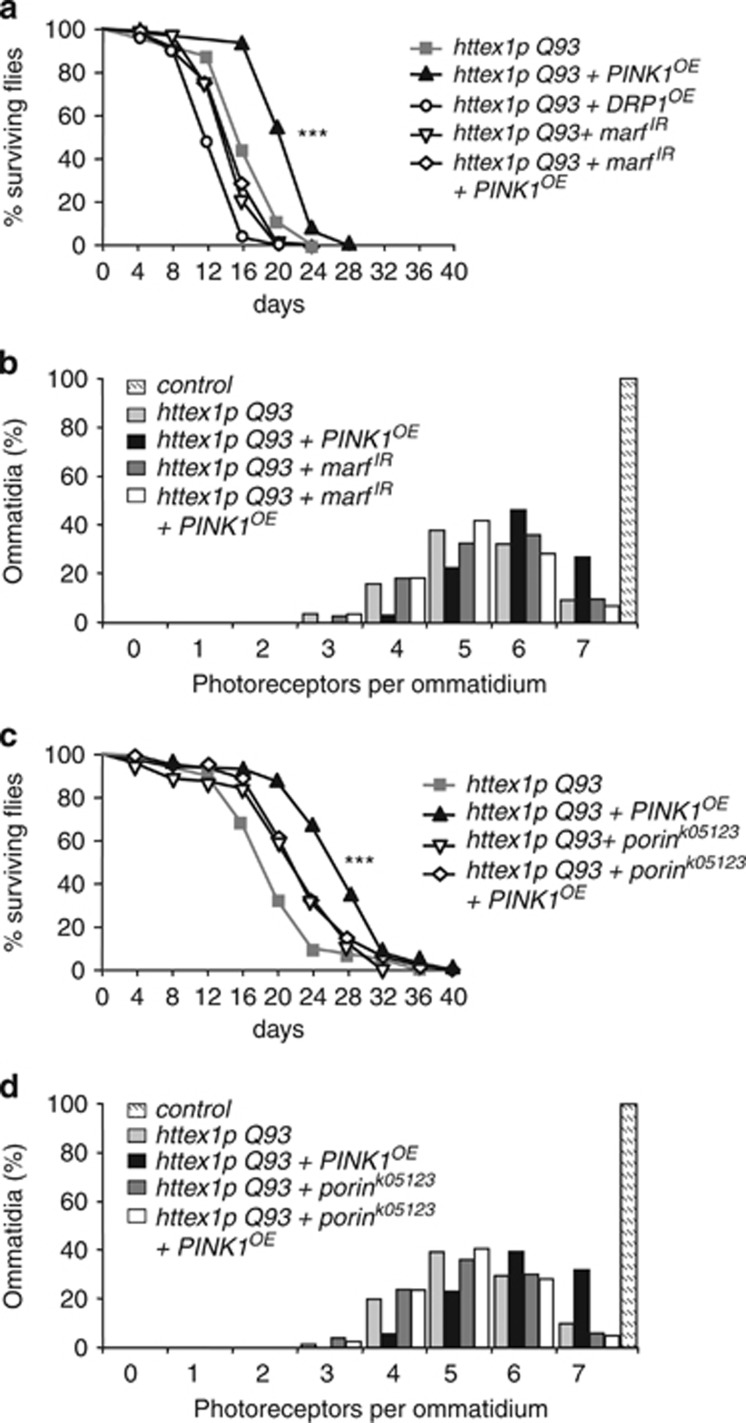
Decreasing Mfn/Marf and VDAC/Porin reduce PINK1 neuroprotective effect. (a) Survival rates of flies expressing httex1p Q93 alone, httex1p Q93 with RNA interference (RNAi) against mfn/marf (marfIR), httex1p Q93 with a DRP1 transgene (DRP1OE), httex1p Q93 with PINK1OE or httex1p Q93 together with PINK1OE and marfIR in neurons. Silencing Mfn/Marf reduces the PINK1 neuroprotective effect on the survival of HD flies. Statistical significance was determined by the log-rank test (n>60 flies per genotype; ***P<0.0001). (b) Number of photoreceptors per ommatidium in 4-day-old flies expressing no transgene (control), httex1p Q93 alone, httex1p Q93 with PINK1OE, httex1p Q93 with the RNAi transgene marfIR or httex1p Q93 together with PINK1OE and marfIR in neurons (n=7–10 flies per genotype; P<0.0001, Mann–Whitney U-test). (c) Survival rates of flies expressing httex1p Q93 alone, httex1p Q93 with PINK1OE, httex1p Q93 in the presence of one mutant allele of VDAC/porin (porink05123) or httex1p Q93 together with PINK1OE and porink05123. Loss of function of Porin prevents the PINK1 neuroprotective effect on the survival of HD flies. Statistical significance was determined by the log-rank test (n>60 flies per genotype; ***P<0.0001). (d) Number of photoreceptors per ommatidium in 4-day-old flies expressing no transgene (control), httex1p Q93 alone, httex1p Q93 with PINK1OE, httex1p Q93 with the mutant allele porink05123 or httex1p Q93 together with PINK1OE and porink05123 in neurons. Loss of function of Porin reduces the PINK1-mediated rescue of photoreceptor loss in HD flies (n=6 flies per genotype; P<0.0001, Mann–Whitney U-test)